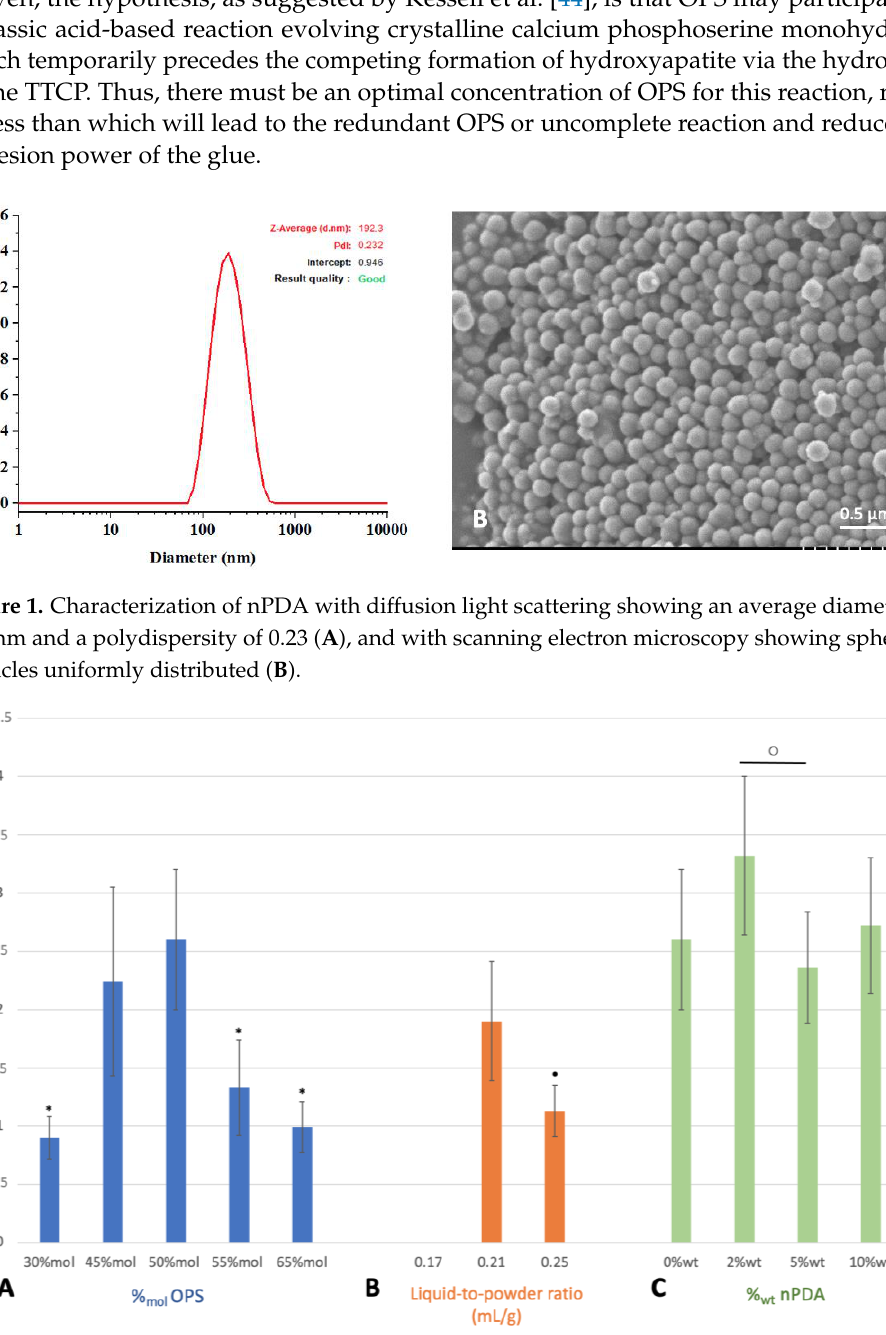
Figure 2. Instrumental tensile adhesion test using titanium cylinder samples evaluating adhesion after 1 h immersion in a 37 °C PBS bath in order to optimize the formulation of the bone glue by varying: ( A ) the molar percentage (% mol ) of OPS in the TTCP/OPS mixture, ( B ) the liquid-to-powder ratio (mL/g), and ( C ) the nPDA content (% wt ). A statistically significant difference was shown: in ( A ) by * ( p < 0.05) compared to the group “50% mol OPS”, in ( B ) by “ ” ( p = 0.016) compared to the group “liquid -to- powder ratio 0.21 mL/g” , and in ( C ) by “ ○ ” ( p = 0.013) between the marked groups.